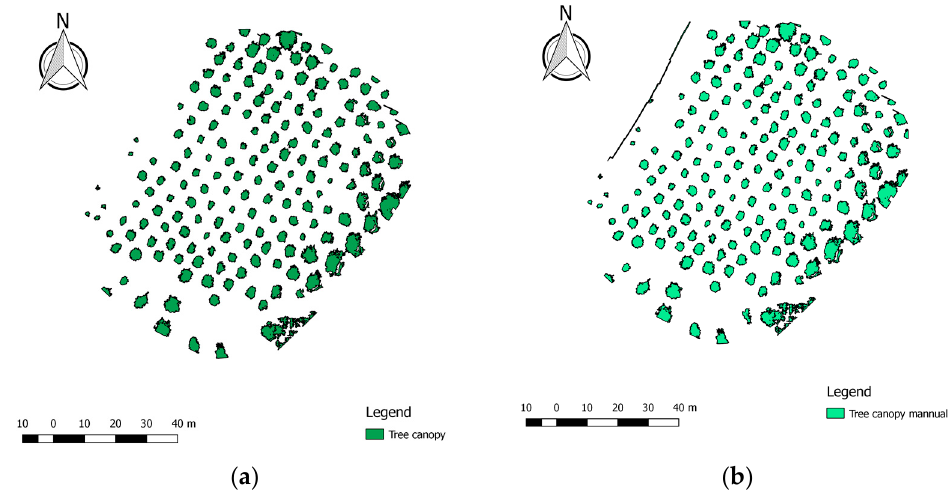
Figure 7. ( a ) Shapefile obtained with the plugin; and, ( b ) shapefile obtained with the manual process.